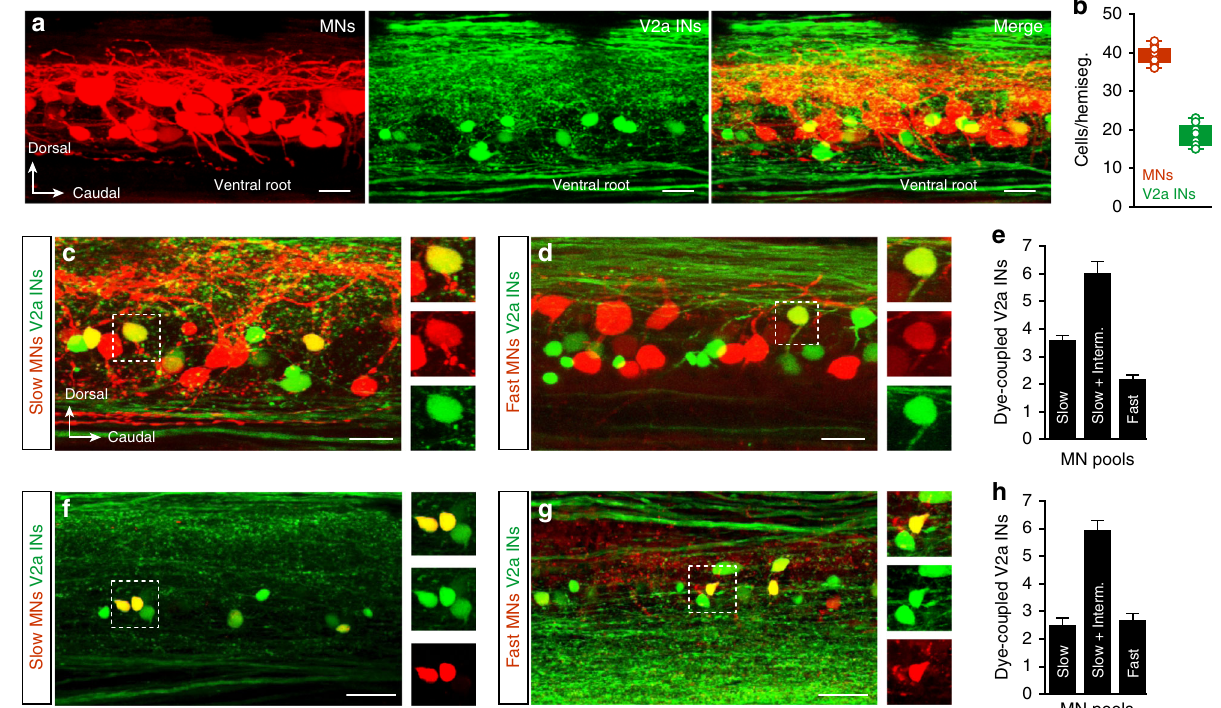
Fig. 1 Distribution of motoneurons and V2a interneurons. a Lateral view of the spinal cord with retrogradely labeled motoneurons by injection of Rhodamine-dextran into the muscle (left), GFP-expressing V2a interneurons (middle) and the merge of the two (right). b There were more motoneurons than V2a interneurons in each hemi-segment of the spinal cord ( n = 13 animals, the boxes are bound by the 25th and 75th percentiles, whiskers extend from min. to max.). c – e Number of segmental V2a interneurons dye-coupled to slow, intermediate and fast motoneurons ( n = 14 animals, error bars in the graph re fl ect the s.e.m.). f – h Number of intersegmental V2a interneurons in the 4 adjacent segments (2 rostral and 2 caudal) dye-coupled to slow, intermediate and fast motoneuron pools ( n = 14 animals, error bars in the graph re fl ect the s.e.m.). Scale bars, 20 µ